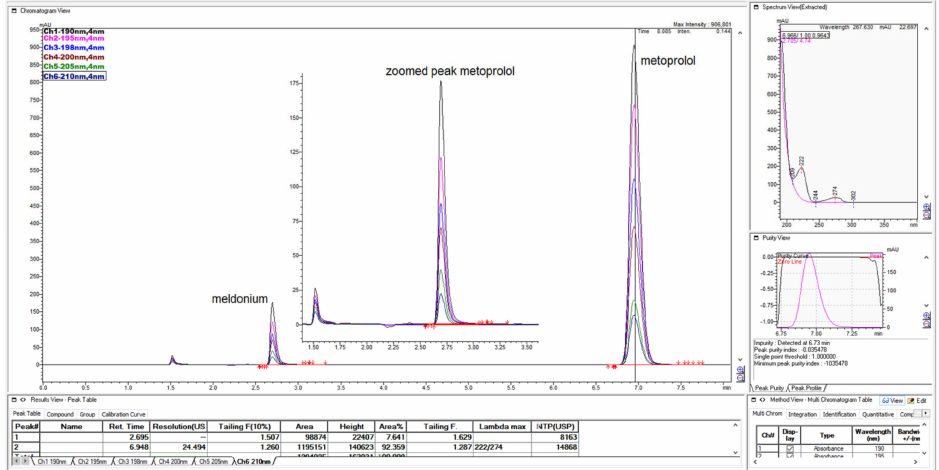
Figure 15. Chromatograms present expanded view of meldonium peaks with system suitability parameters below in the table, monitored and recorded at 5